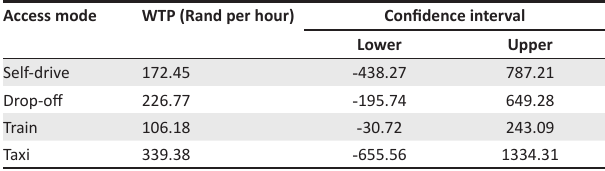
TABLE 4: Access time willingness-to-pay of respondents. Access